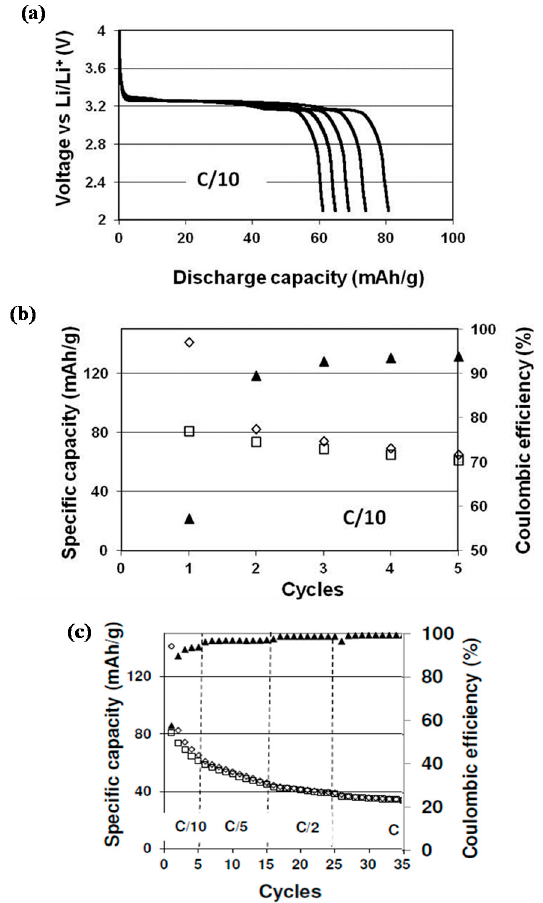
Figure 5. ( a ) Discharge capacity profiles at C/10, ( b ) charge ( □ ) and discharge ( ◊ ) capacity and coulombic efficiency ( ▲ ) as function of cycles at C/10, ( c ) charge/discharge capacity as a function of the current rate.